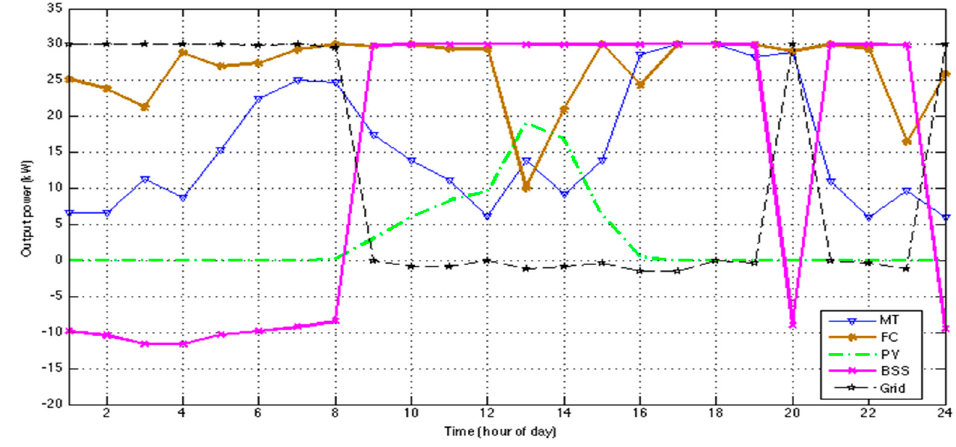
Figure 3. DERs power generation contribution in optimal operation.